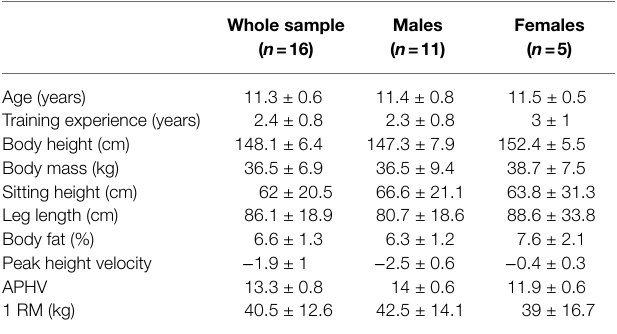
TABLE 1 | Participants’ anthropometric and dynamic strength characteristics in the whole sample, male and female young